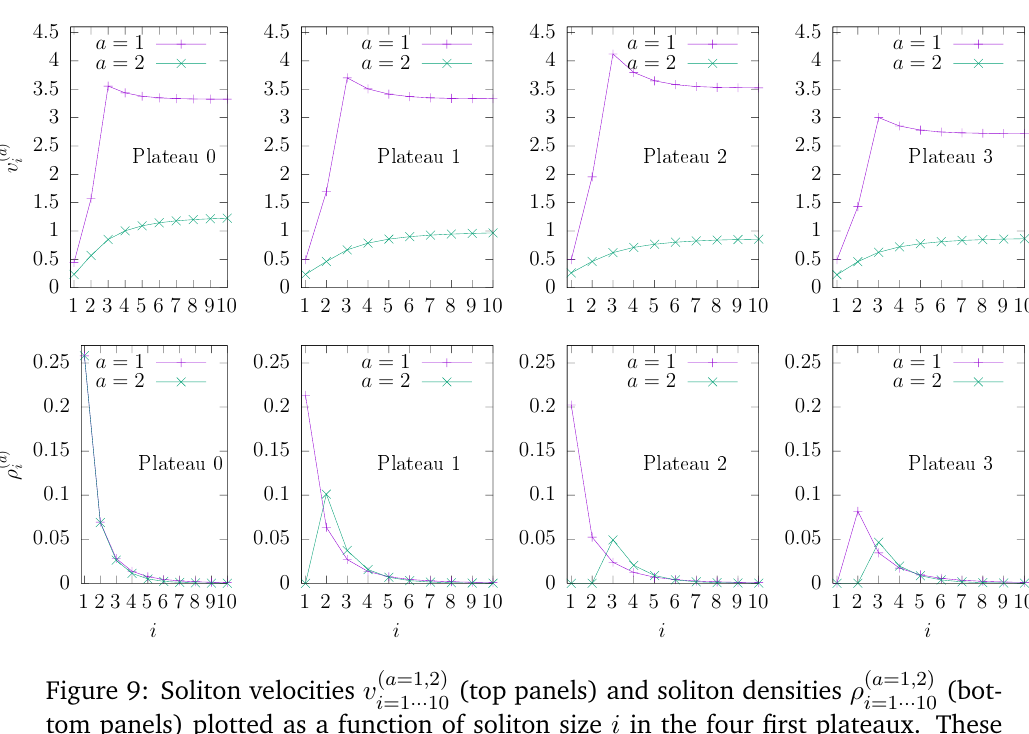
( a =1 , 2) Figure 9: Soliton velocities v (top panels) and soliton densities ρ i =1 ··· 10 tom panels) plotted as a function of soliton size i in the four first plateaux. These curves are obtained from GHD calculations and for the same parameters as in Fig. 6, ( r =1) that is with the T dynamics, fugacities z 1 ,L = 1 z 2 ,L = 0 . 7 , z 3 ,L = 0 . 3 and with l =3 the vacuum state in the right part at t = 0